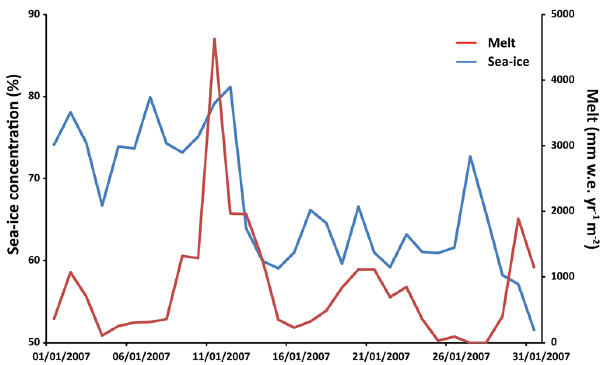
Figure 14. Daily sea ice concentrations and RACMO2.3 derived melt during January 2007 in Porpoise Bay. Sea ice concentrations start to decrease after the melt peak on 11